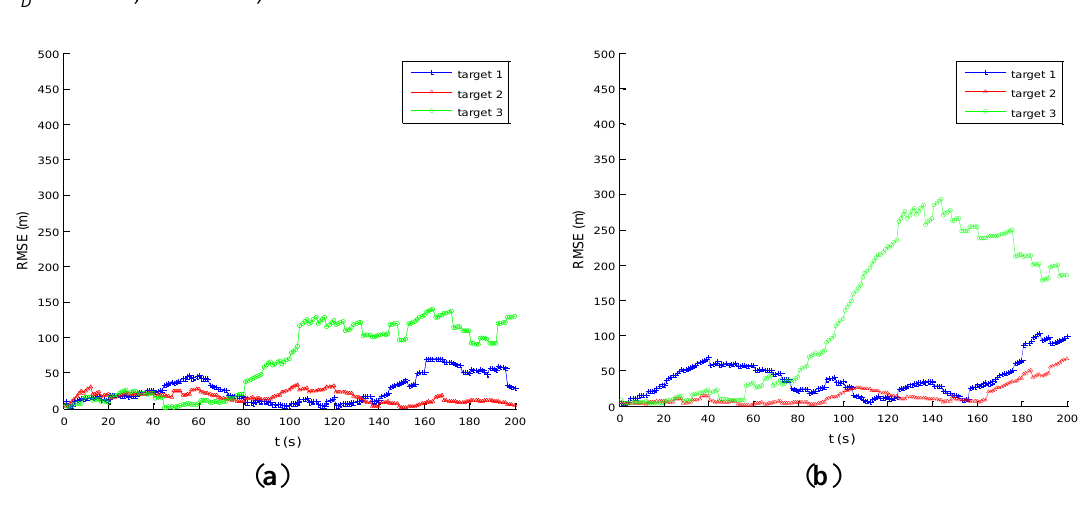
Figure 7. RMSE of position for high measurement